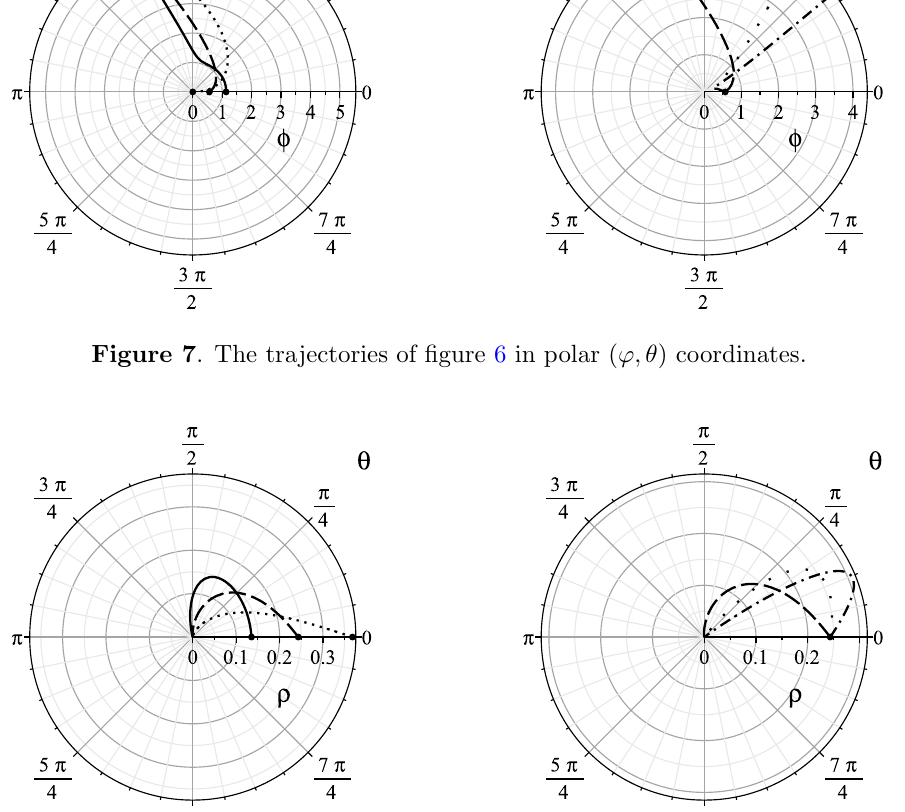
Figure 8 . The trajectories